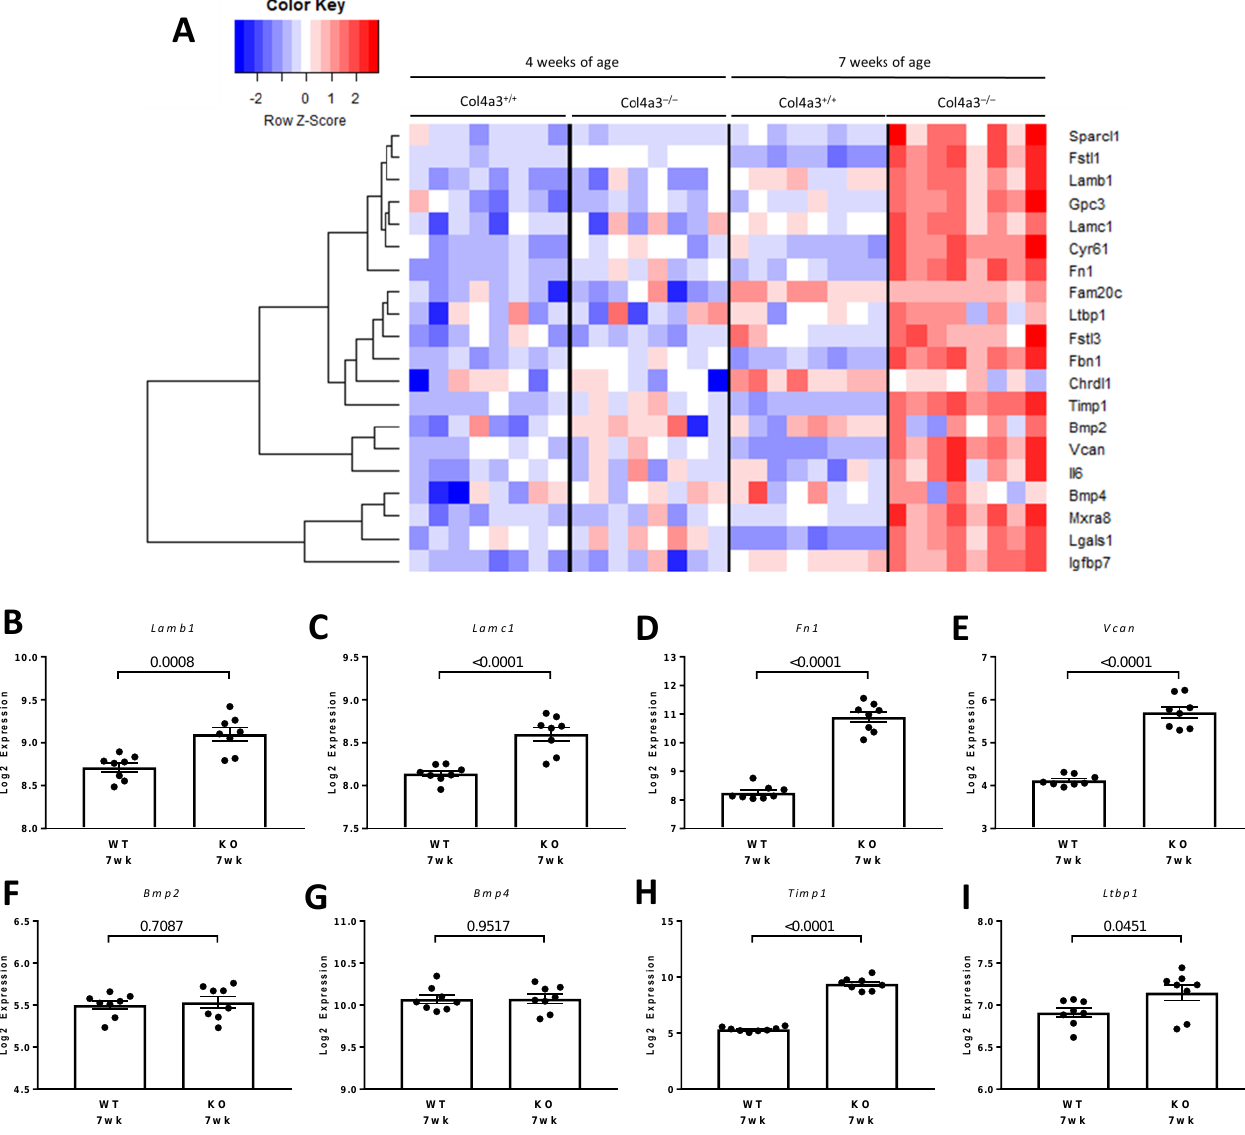
Figure 16. Expression analysis of FSTL1 signature genes derived from the STRING analysis of the FSTL1 protein–protein interaction (PPI) network. ( A ) Heat map with unsupervised hierarchical cluster analysis of the FSTL1 driven PPI network genes in kidneys of 4 and 7 week old Col4a3 -/- mice and wild-type mice ( n = 8 per group). ( B – I ) Graphical representation of mRNA levels for selected FSTL1 signature genes in 7 week old wild type versus 7 week old Col4a3 -/- mice. Values are the mean ± SEM (black bars). p values were determined by Student’s t tests, and significance was defined as a p value < 0.05.